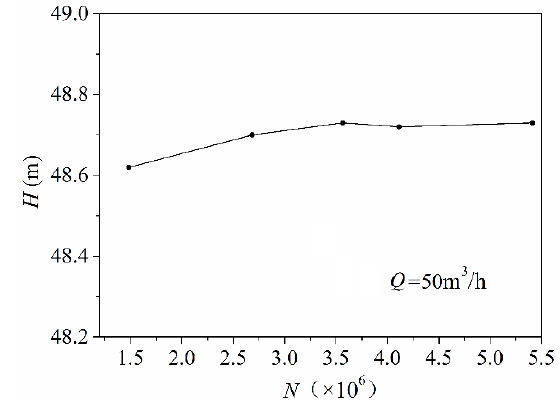
Figure 5. Grid independent test.